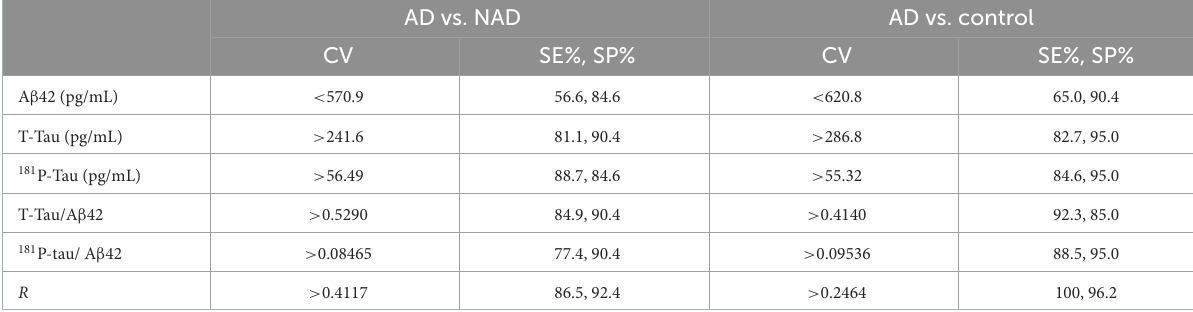
TABLE 3 Cutoff values and corresponding sensitivity/specificity.